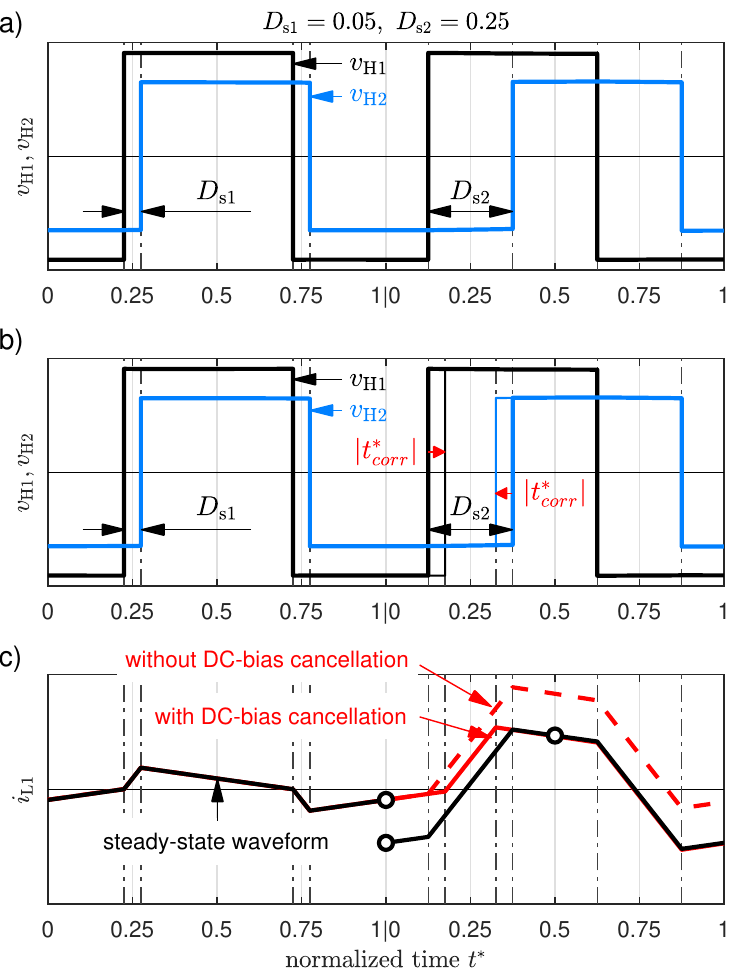
Figure 2. Exemplary waveforms explaining the used modulation scheme during transition of the phase shift value: ( a ) AC voltages when a basic Double-Sided Single Phase Shift (DSSPS) modulation is applied, ( b ) AC voltage waveforms when the Dual Rising Edge Shift (DRES) algorithm for DC-bias cancellation is additionally applied, and ( c ) transformer current